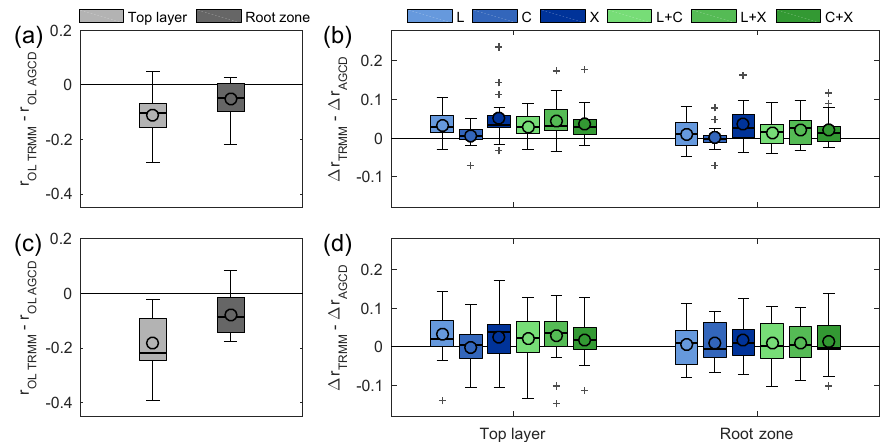
Figure 7. The difference in open-loop model performance based on r (a) and the difference between the impact of data assimilation based on (cid:49)r (b) between experiments using TRMM and AGCD precipitation data. Panels (c) and (d) show the same for anomaly time series. Box plots are defined as in Fig.